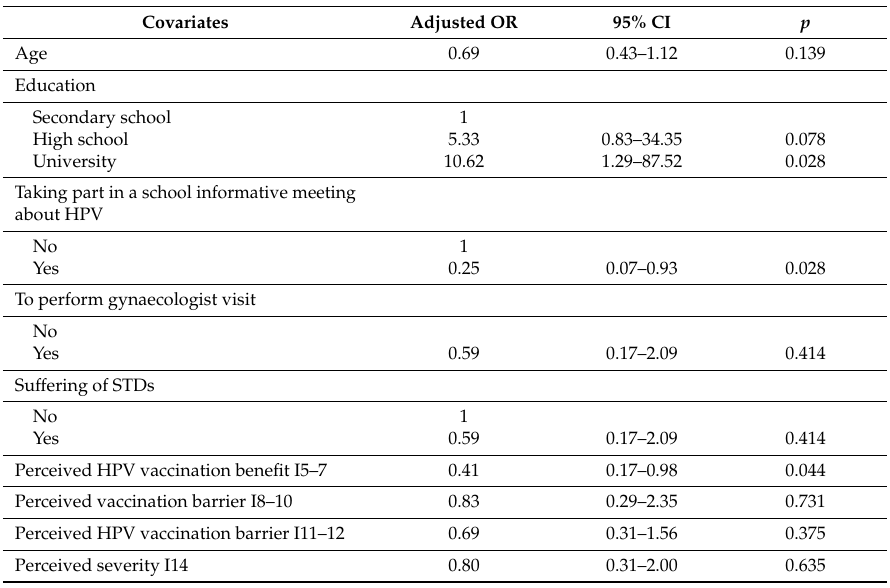
Table 3. Multivariate logistic regression of factor associated with refusal of HPV